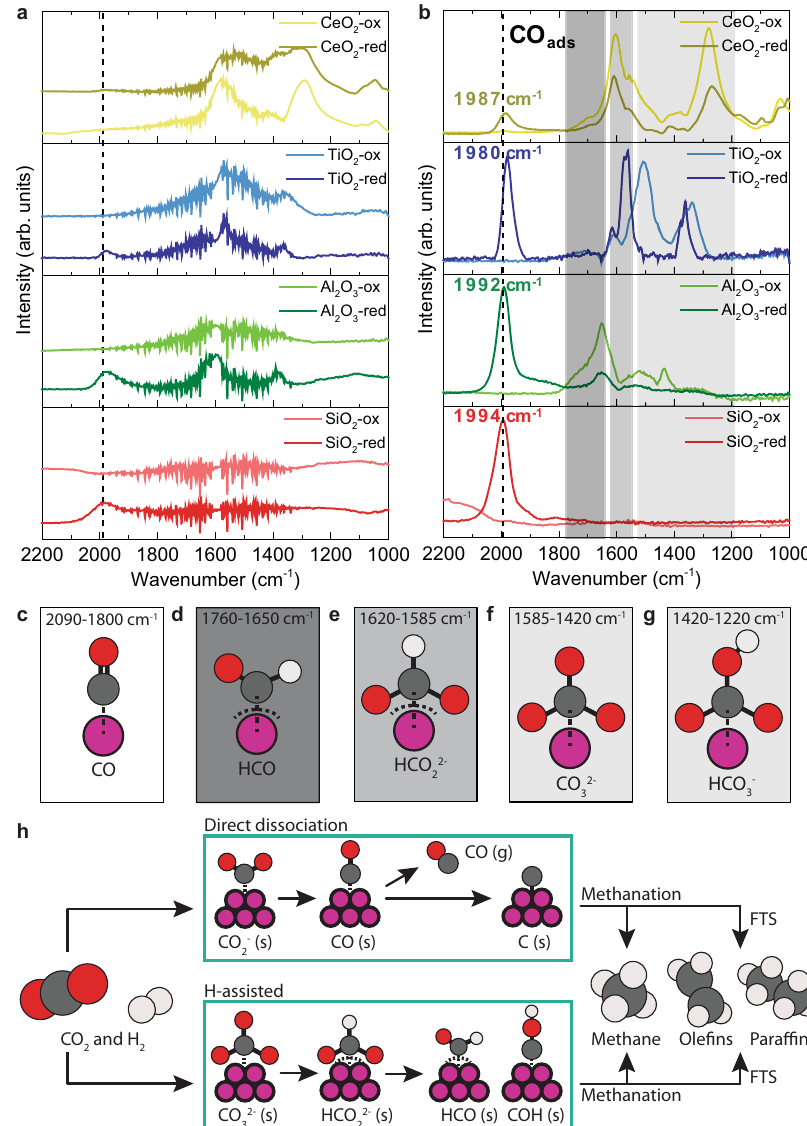
Fig. 2 Modulated excitation diffuse re fl ectance infrared Fourier transform spectroscopy (ME DRIFTS) during CO 2 hydrogenation with the cobalt- based catalysts. a Averaged time-resolved DRIFT spectra and b phase-resolved amplitude spectra of CoO (suf fi x: -ox) and metallic Co (suf fi x: